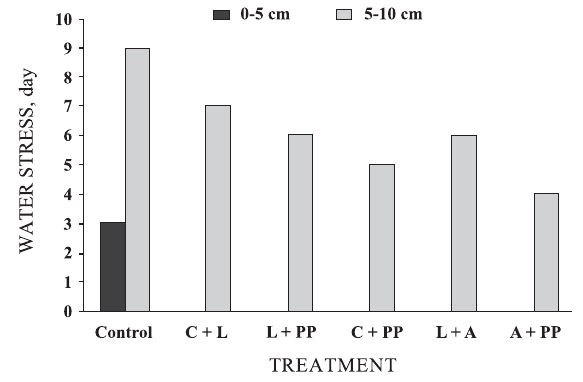
Figure 2. Days in which the root hospitality factor was below the critical level in the soil layer 0 - 10 cm. C+PP: clitoria + pigeon pea; L+PP: leucaena + pigeon pea; A+PP: acacia + pigeon pea; C+L: clitoria + leucaena; L+A: leucaena +